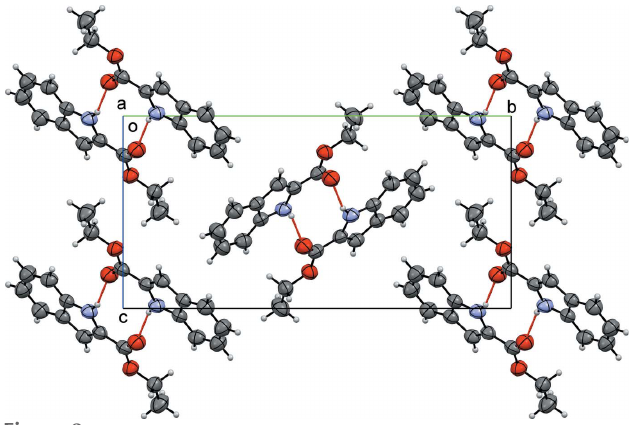
Figure 2 Crystal packing diagram of title compound viewed along [100]. Hydrogen bonds are coloured red.